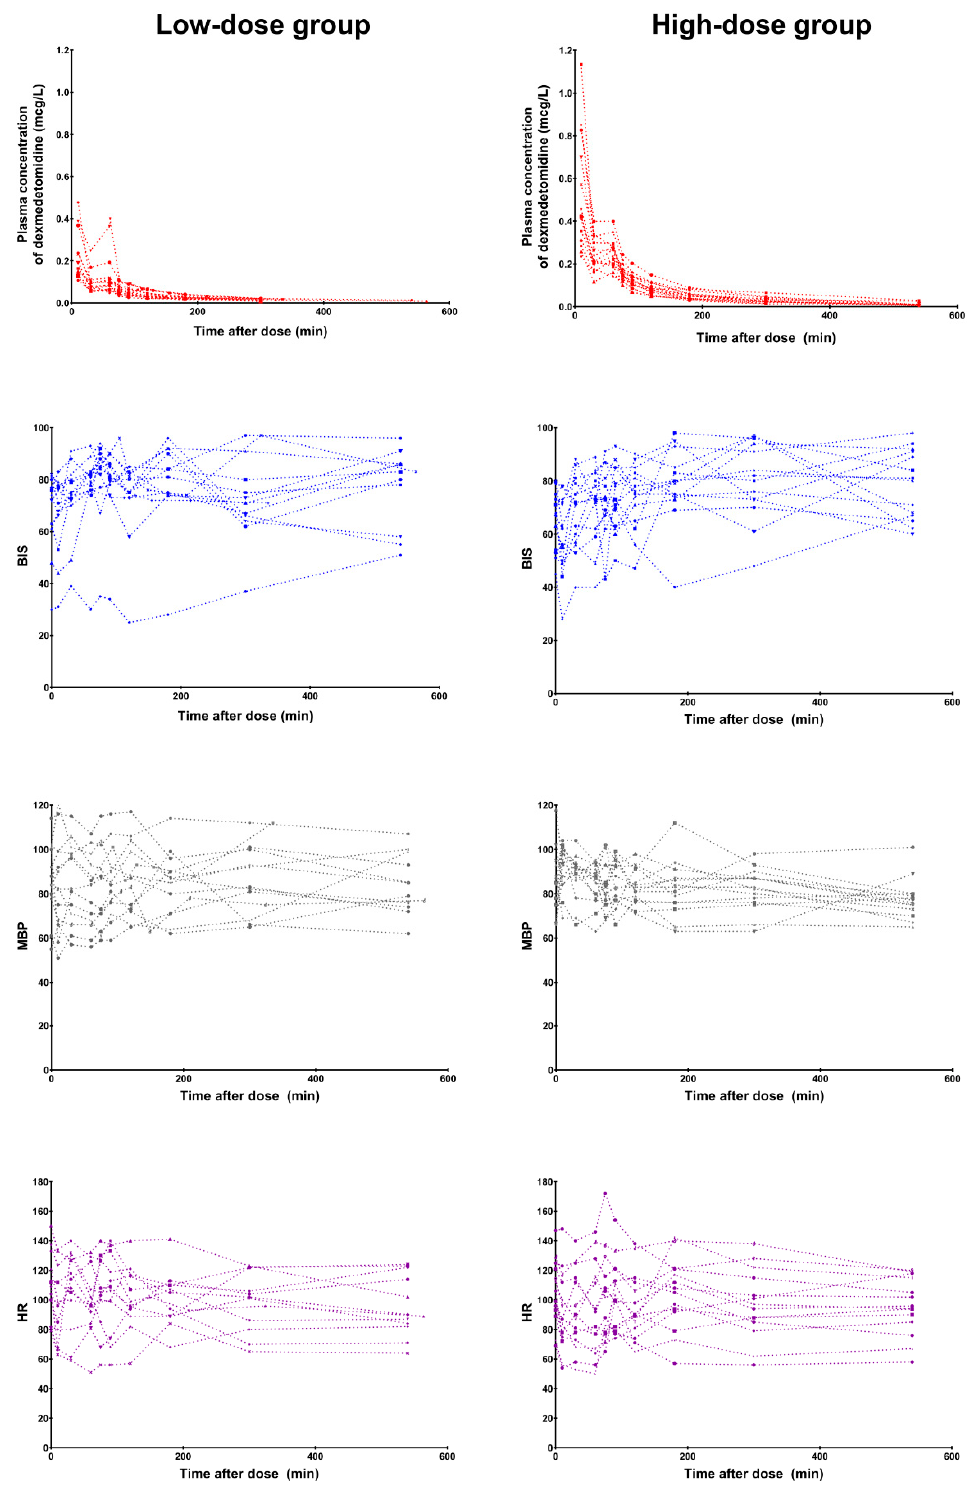
Figure 1. The observed plasma concentrations of dexmedetomidine (1st row), Bispectral Index (BIS, 2nd row), mean blood pressure (MBP, 3rd row), and heart rate (HR, 4th row) over time by dose group. Time after dose: time after starting the loading dose of dexmedetomidine.